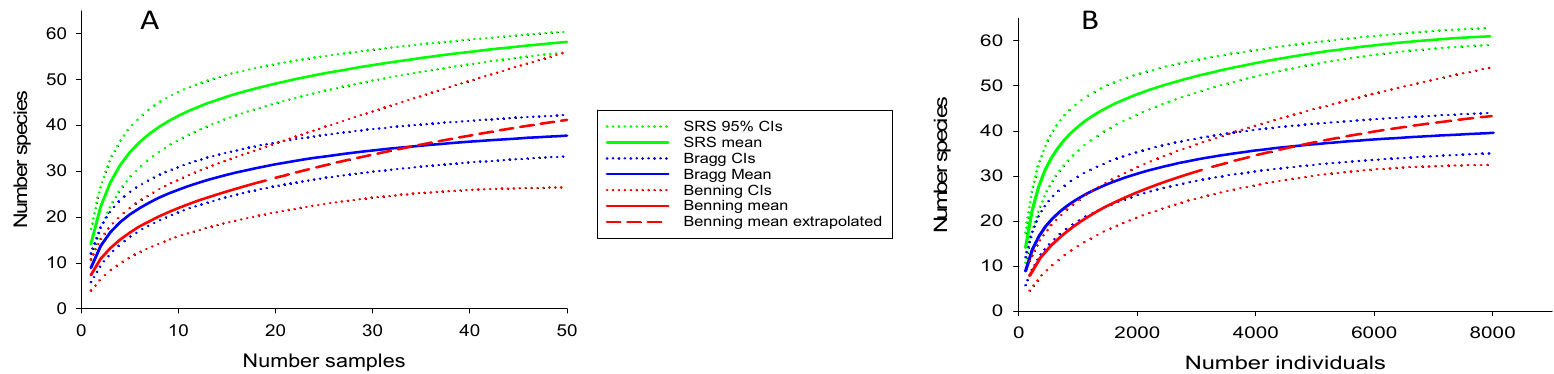
Figure 5. Species accumulation curves for the Savannah River Site (SRS), Fort Bragg, and Fort Benning. Curve ( A ) shows relationship between number of species and samples (species density), and ( B ) shows relationship between number of species and individuals captured (species richness).